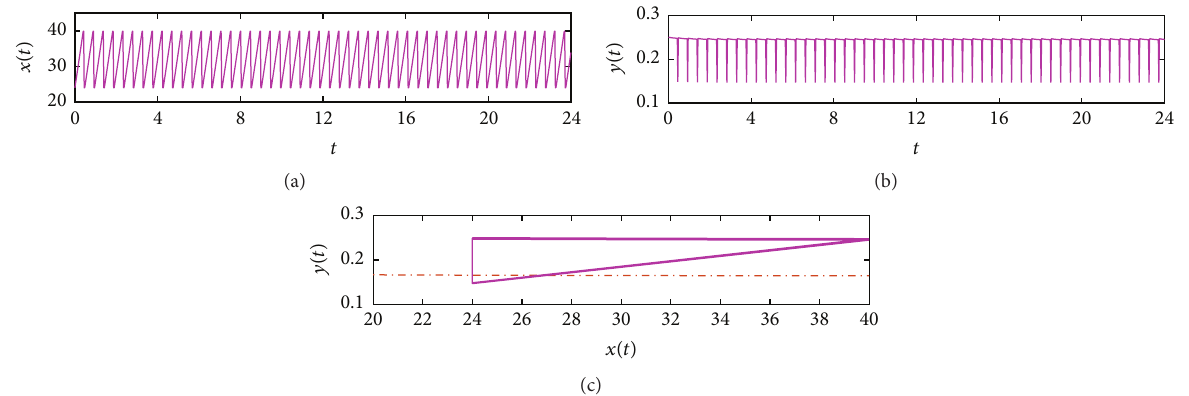
Figure 4: The change in prey density (a), predator density (b), and phase diagrams (c) starting from (𝑥 0 ,𝑦 0 ) = (24, 0.25) with 𝑝 = 0.4 , 𝑞 = 0.4 , = 20 , ℎ = 40 , 𝑦 (ℎ ) = 0.1664 , 𝑦 ((1 − 𝑝)ℎ ) = 0.1651 , and 𝛼 ℎ 1 2 𝜏 1 𝜏 2